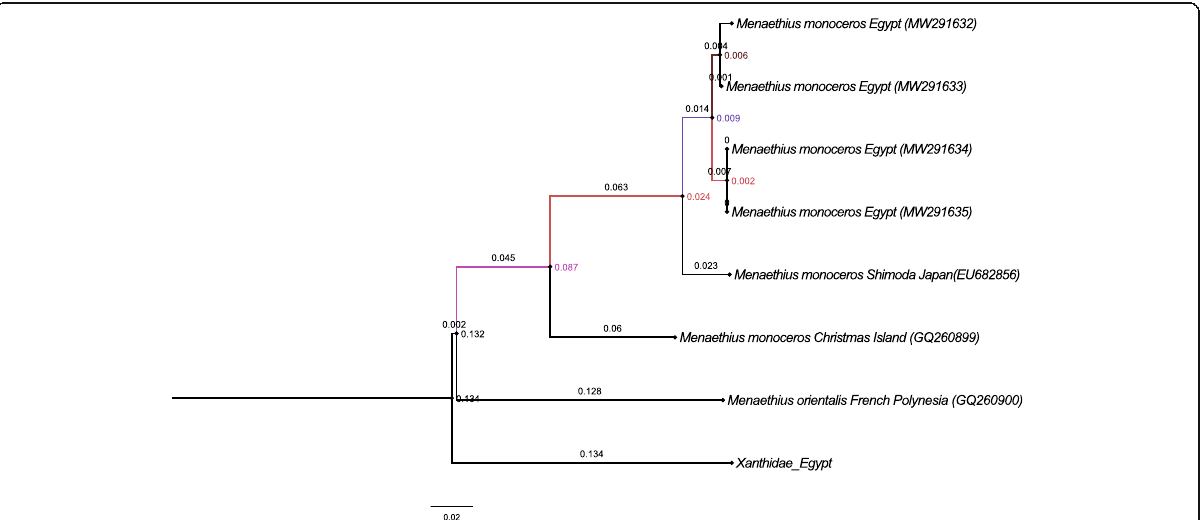
Fig. 3 Evolutionary relationships of selected taxa sequences with COI using the Neighbor-Joining method with a bootstrap test (1000 replicates). Evolutionary distances were computed using the Tamura 3-parameter method; the rate variation among sites was modeled with a gamma distribution (shape parameter = 1)